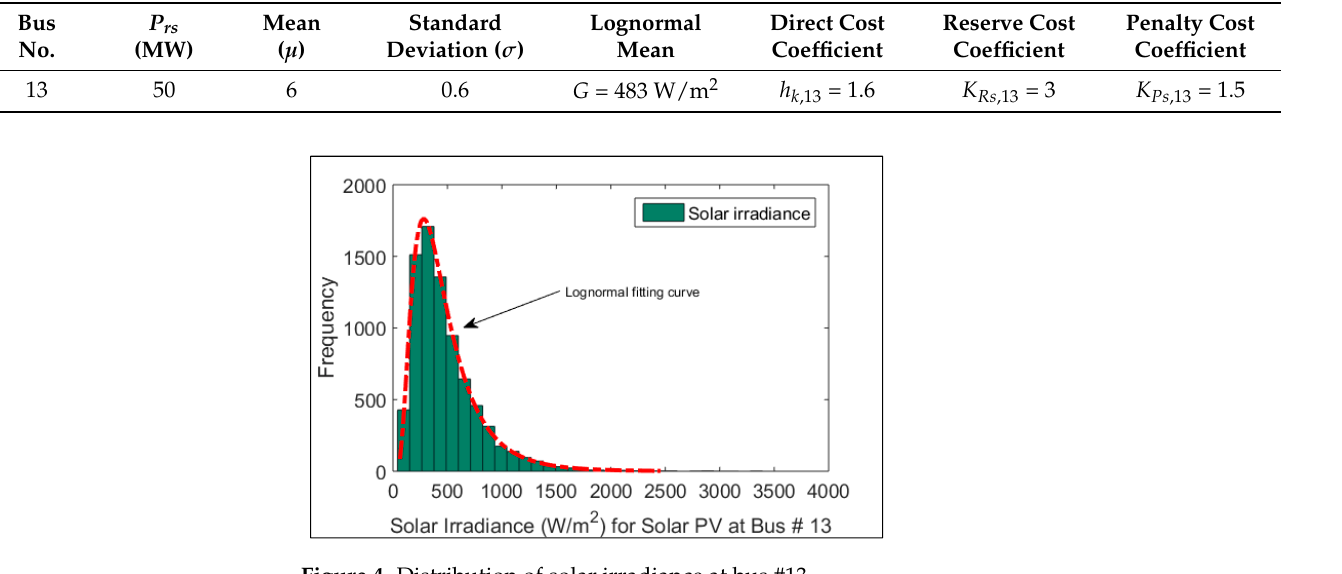
Table 4. SPV source PDF parameters and cost coefficients.